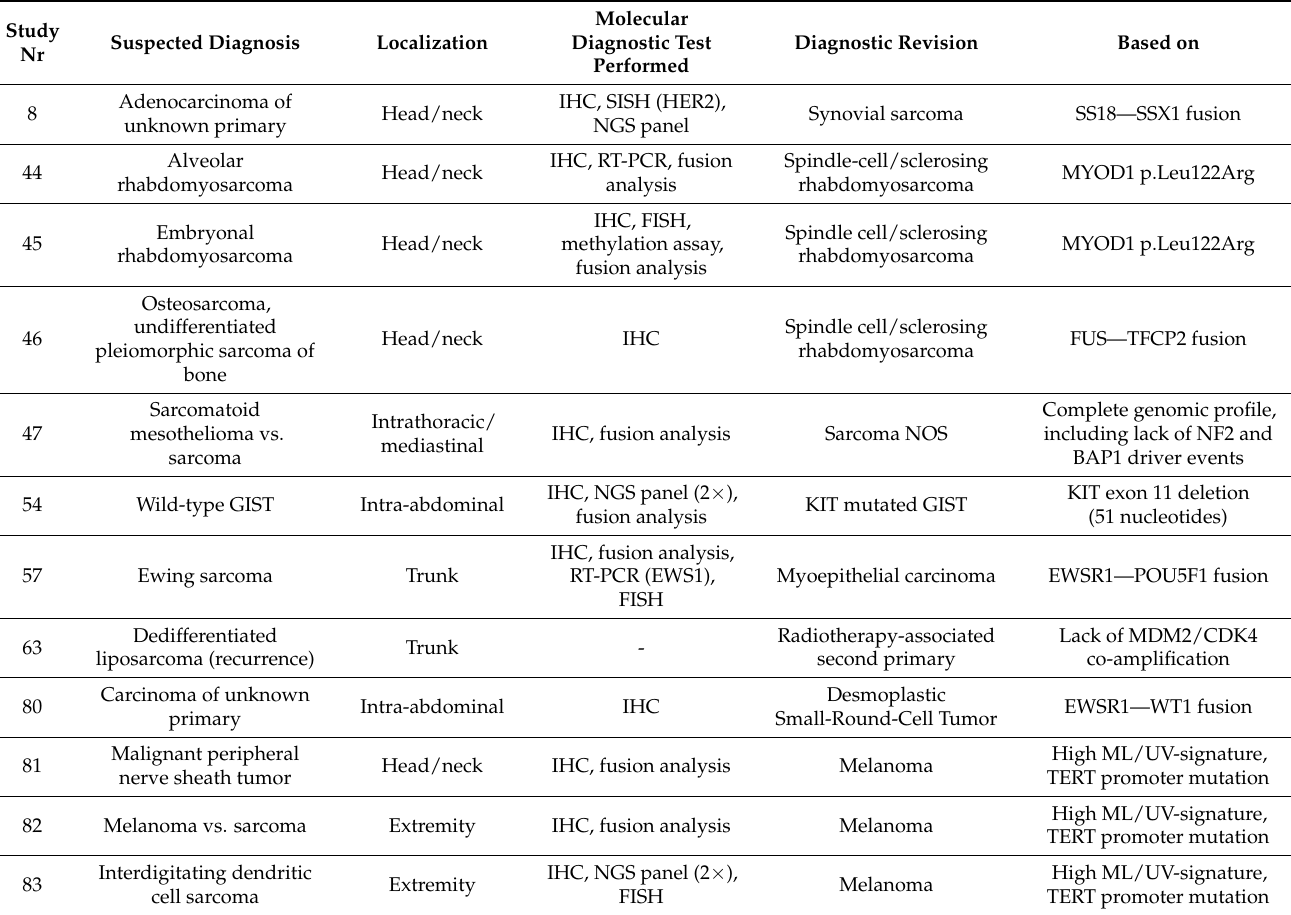
Table 2. Diagnostic revisions based on WGS